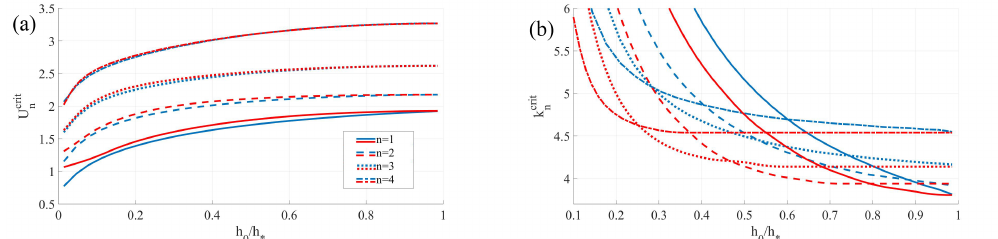
Figure 7. The critical speeds of the first four modes as a function of the parameter h 0 / h ∗ ( a ). Corre- sponding wave numbers of critical speeds ( b